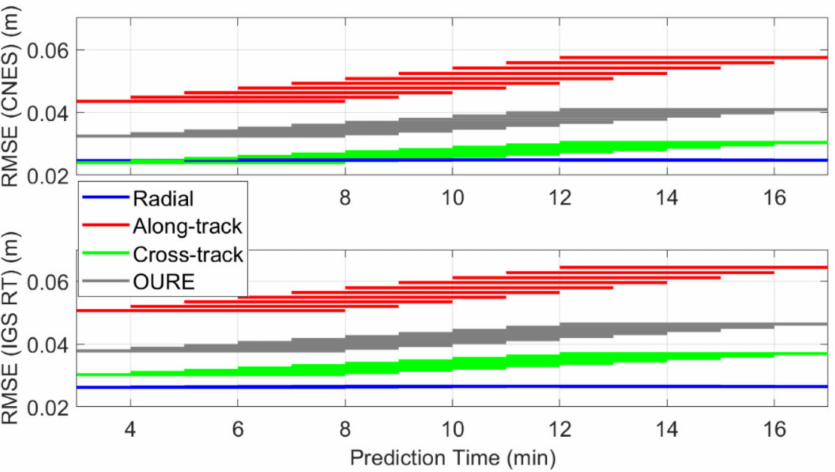
Figure 6. RMS of the orbital prediction errors of Sentinel-3B for different prediction time windows. The CNES real-time products ( top ) and IGS RTS products ( bottom ) were used for the